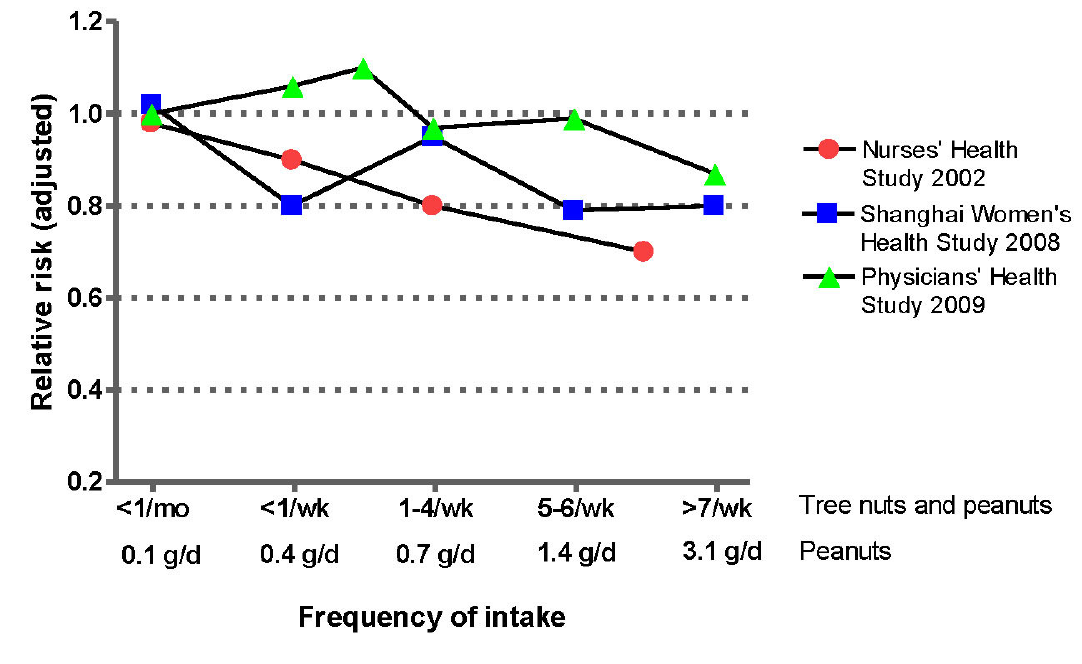
Figure 2 . Results of prospective studies of nut consumption and risk of diabetes. The two US studies considered the frequency of consumption of all nuts, including peanuts, while the Chinese study considered exclusively quintiles of peanut consumption in